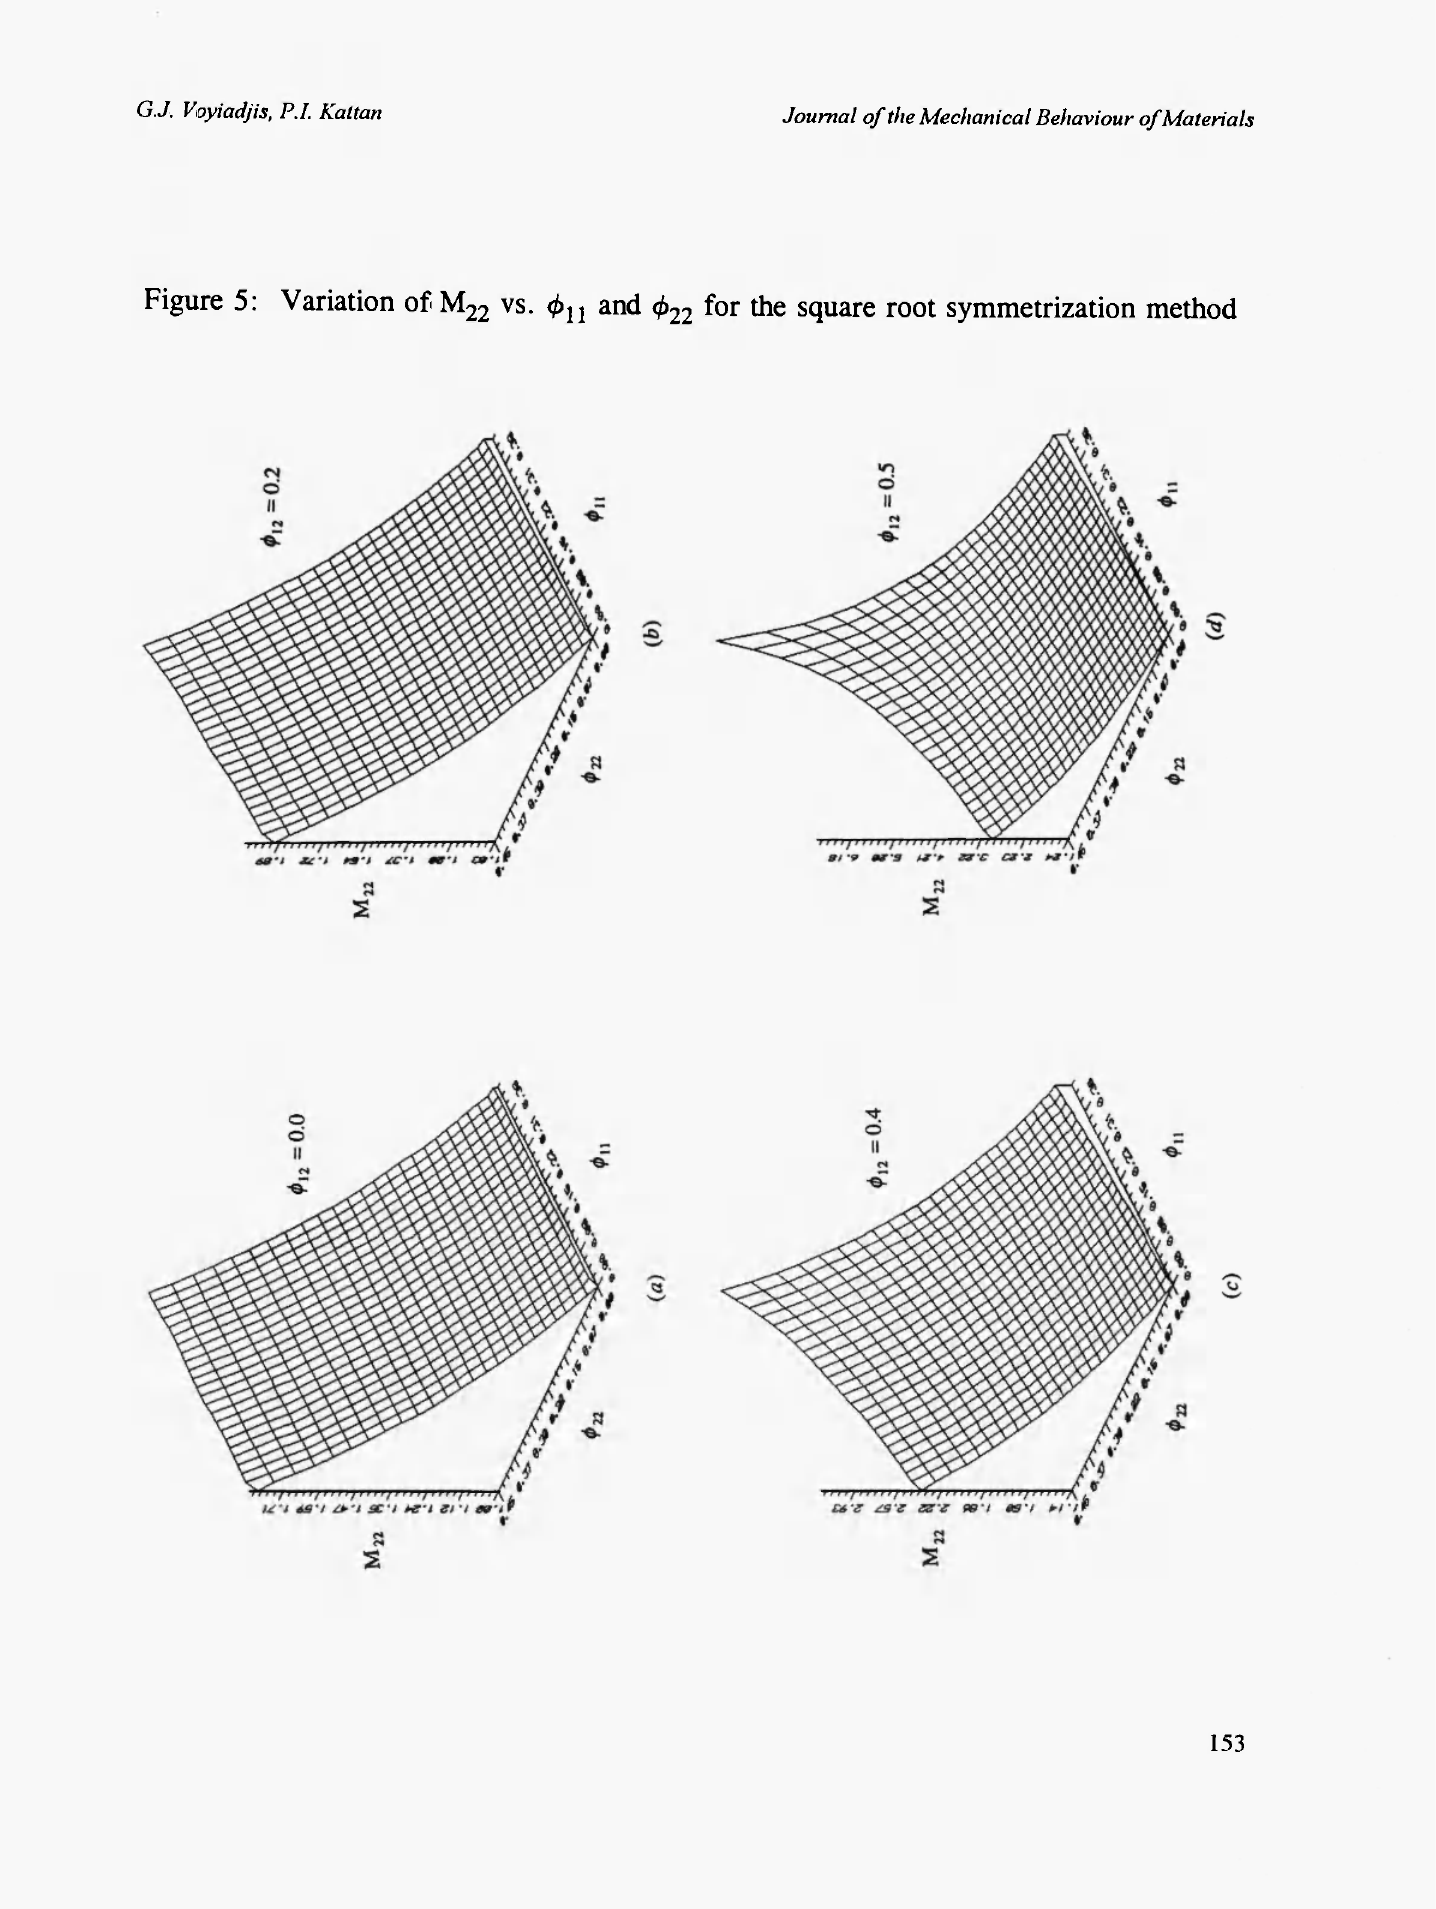
vs. φ and φ for the square root symmetrization 22 η 22